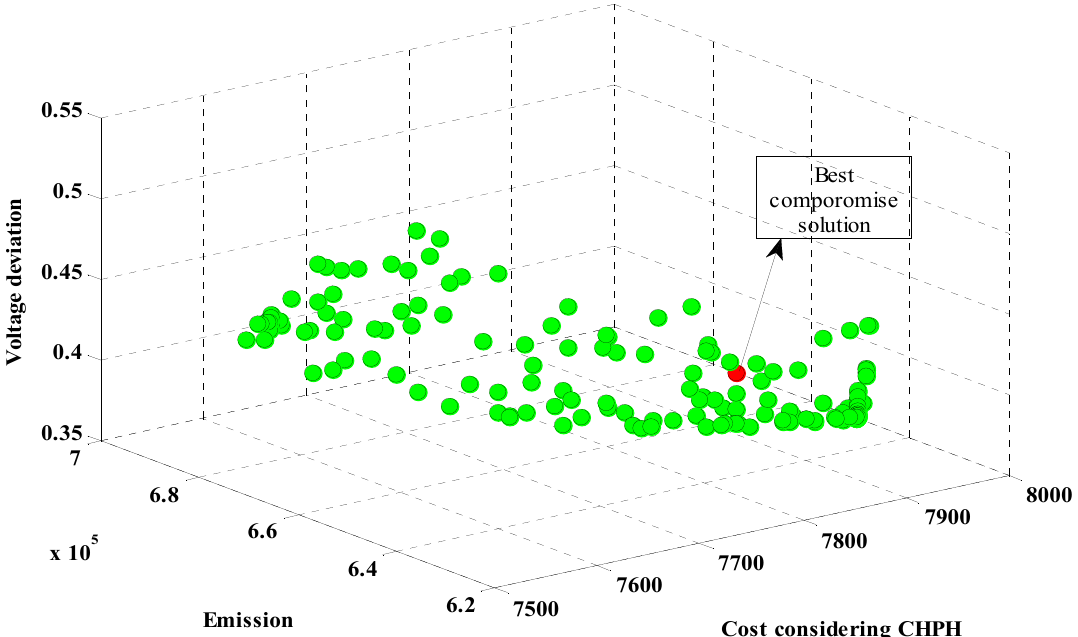
Figure 13. Pareto front for cost considering strategy 4, emission and voltage deviation objective